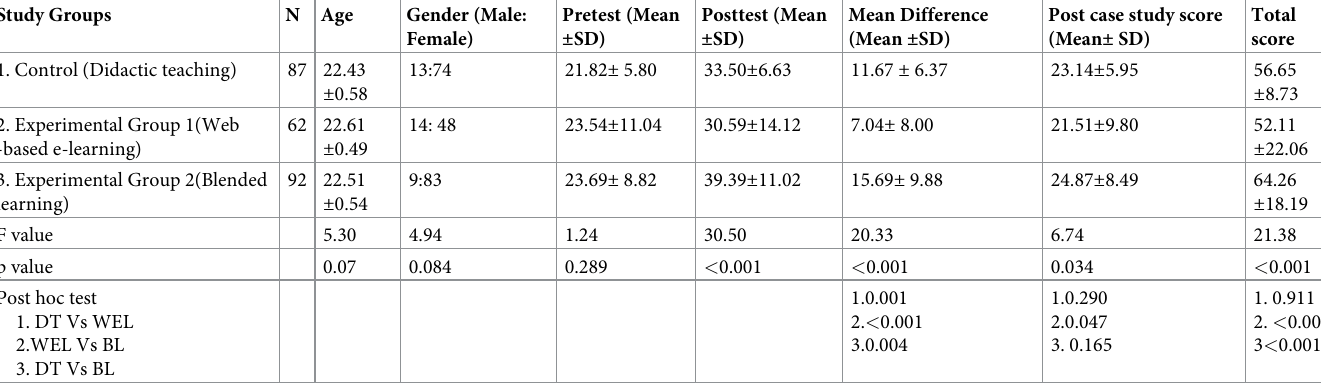
Table 2. Comparison of knowledge score between learning